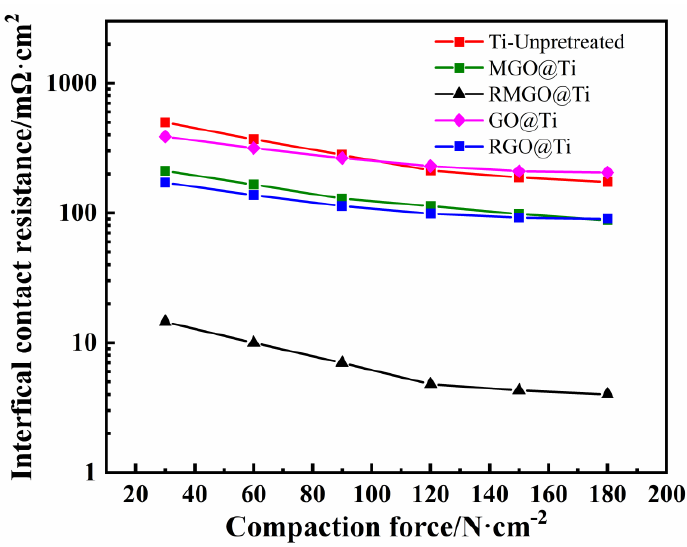
Figure 4. The interfacial contact resistance (ICR) of Ti-Unpretreated, MGO@Ti, RMGO@Ti, GO@Ti, and RGO@Ti.